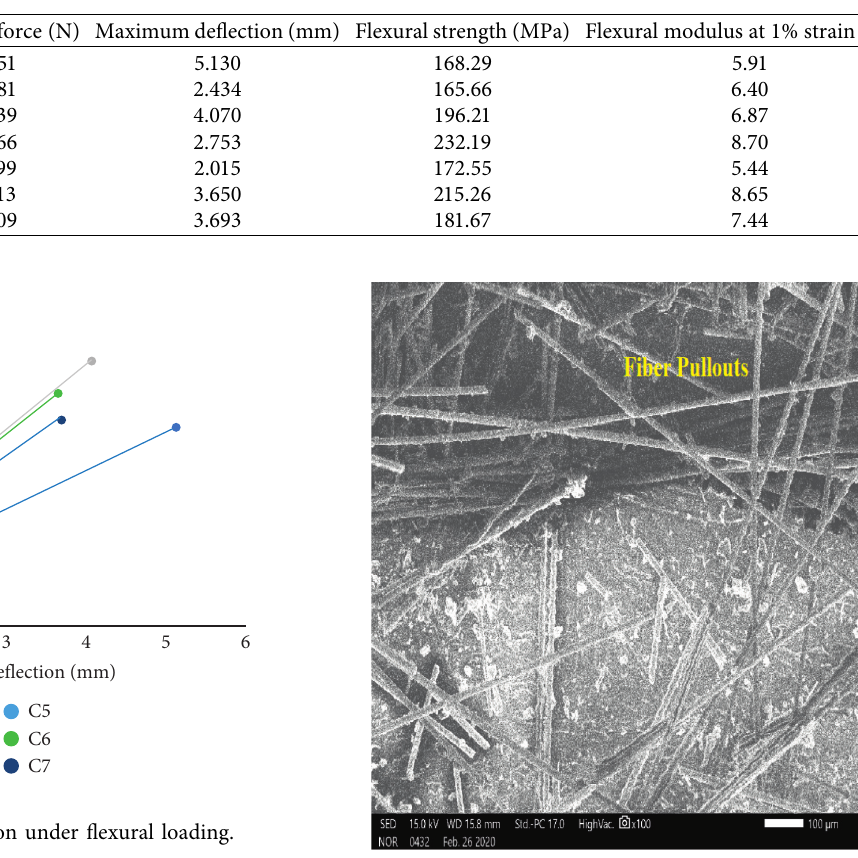
Figure 4: Scanning electron microscopy image of flexural test specimen with grey cement filler of 15